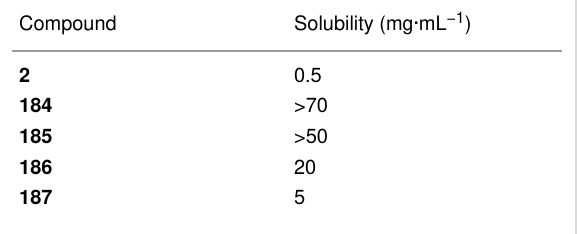
Table 3: Solubility comparison of combretastatin D-2 ( 2 ) and prodrugs in water at 25 °C [55].